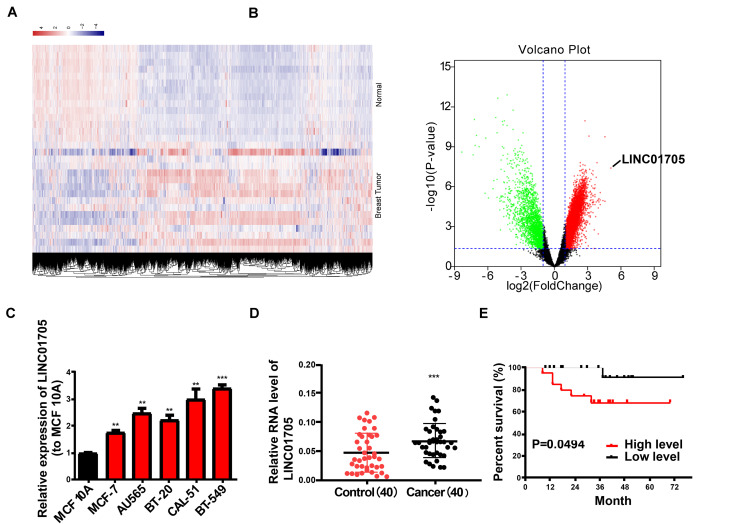
Features and expression of LINC01705 in breast cancer. (A) Heatmap and (B) volcano plot describing the dysregulation of 8602 lncRNAs, including the upregulation of 6131 lncRNAs, in breast cancer tissues (fold change >2 or <0.5, P-value < 0.05). (C) qRT-PCR of LINC01705 expression in breast cancer cell lines (MCF-7, BT-549, CAL-51, AU565, and BT-20) and the normal human mammary epithelial cell line MCF 10A. (D) qRT-PCR for the detection of LINC01705 expression in breast cancer tissues and para-carcinoma tissues. (E) A remarkably lower survival rate was observed in patients with high expression of LINC01705 than in patients with low expression of LINC01705. Data was reported as the mean ± s.d. **P < 0.01, ***P < 0.001.